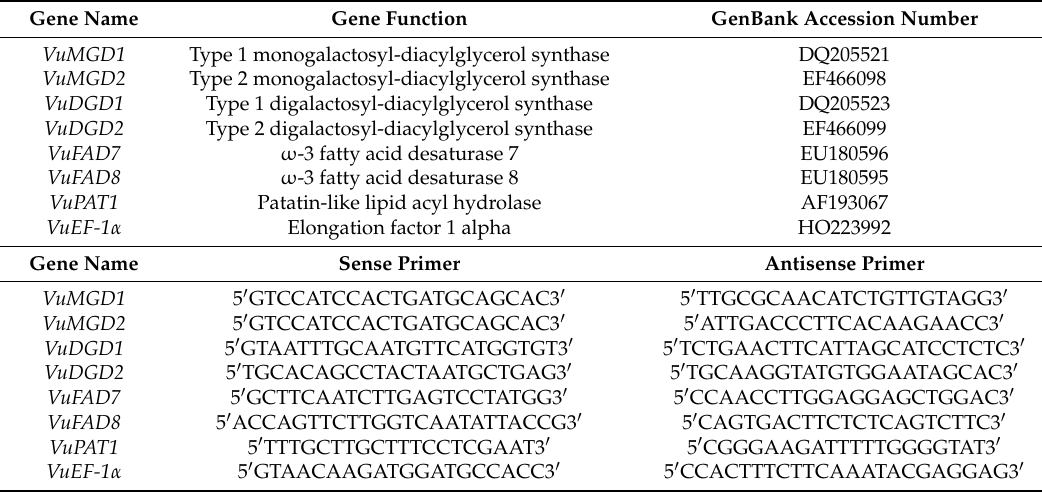
Table A5. Name, function and accession number of genes measured by real-time quantitative PCR as well as sequences of sense and antisense primers used for qPCR